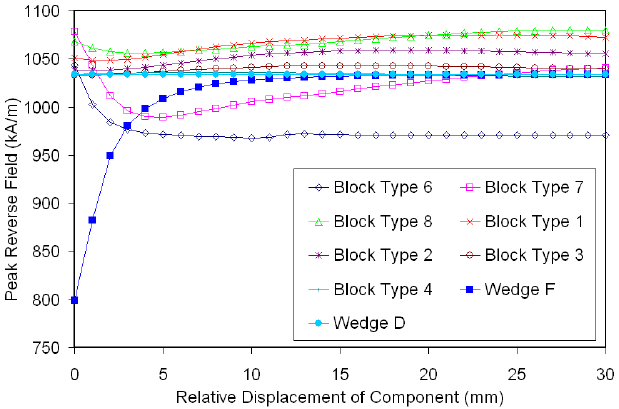
FIG. 14. (Color) The peak demagnetizing field inside the sample block as other blocks and wedges (shown in Fig. 13) are slid into